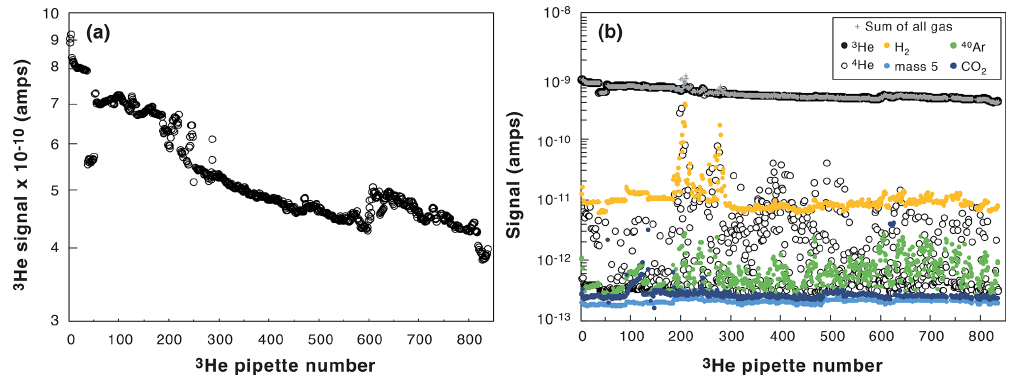
Figure 3. Evolution of the measured 3 He signal with pipette number (from January to June 2019). (a) Decrease in the spike 3 He signal. (b) Evolution of all the measured signals ( 3 He: black dots; 4 He: open black dots; H 2 : orange dots; mass 5 (background noise): light blue dots; 40 Ar: green dots, CO 2 : dark blue dots; crosses: summation of all the signals).